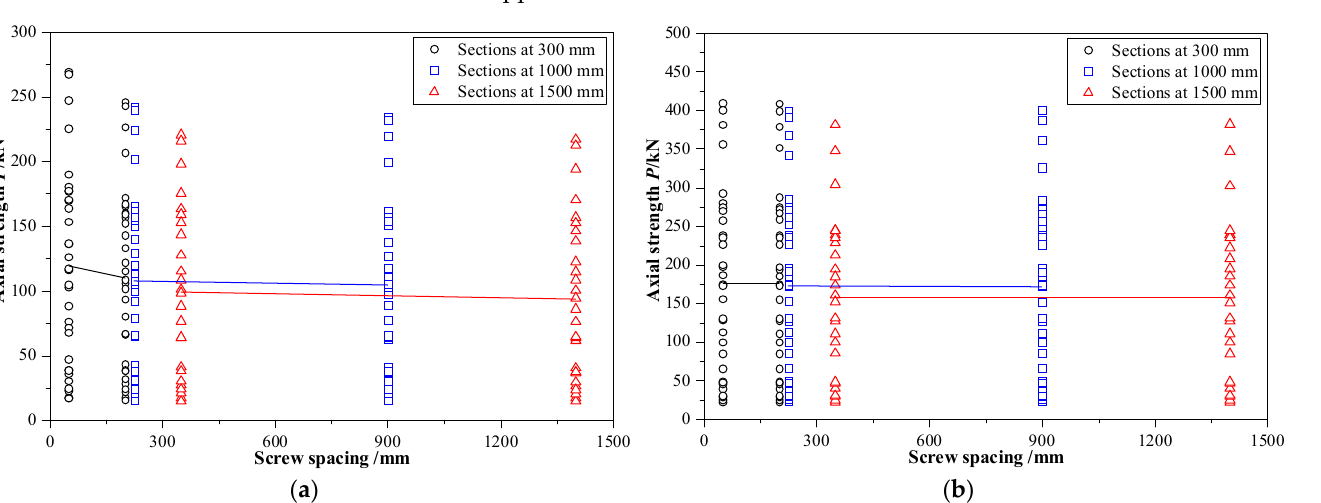
Figure 9. Influence of screw spacings: ( a ) CFS-FTF built-up unlipped channel columns with different screw spacings; and ( b ) CFS-FTF built-up lipped channel columns with different screw spacings.